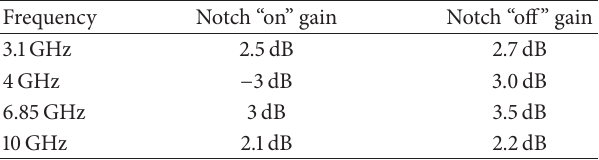
Figure 5: Simulation and measurement of return loss of the antenna when the switch is ON, and the slot disappears. The antenna covers all UWB from 3.1 to 10GHz. Table 1: Gain versus frequency with and without notch.